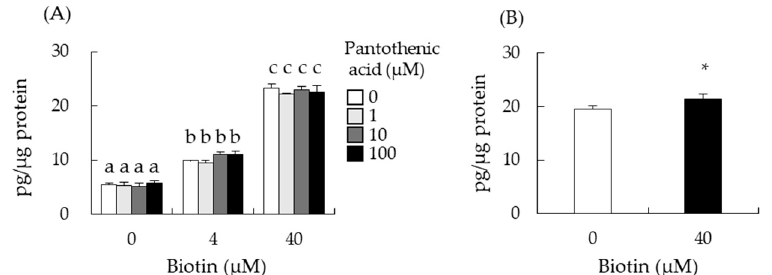
Figure 4. Intracellular transport of biotin did not contribute to the enhancement of testosterone levels. The testosterone levels in the I-10 cells cultured medium with/without biotin and pantothenic acid for 24 h were measured by ELISA ( A ). Free biotin levels in I-10 cell lysates after 24 h of biotin treatment were measured by bioassay using Lactobacillus plantarum (ATCC8014) ( B ). Data are presented as mean ± standard error (n = 3). Values with different letters are significantly different at p < 0.05 vs. 0 µM biotin group, Tukey–Kramer. * p < 0.05, vs. 0 µM biotin group, Student’s t -test.